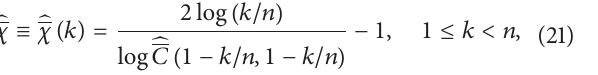
with ̂𝜂 given in (19). From the second equality in (11), it is obtained the estimator